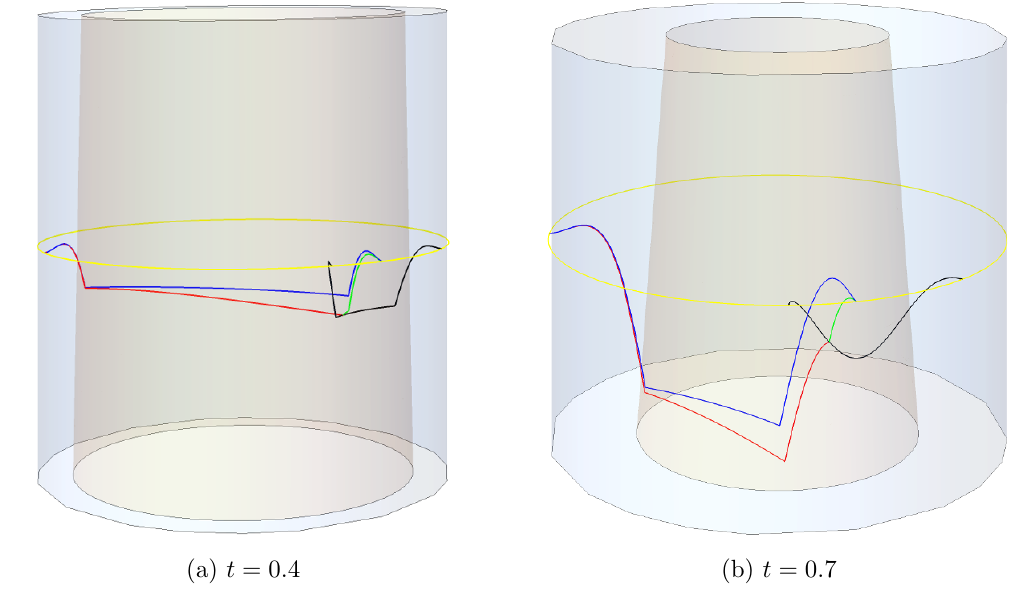
Figure 13. In the (cid:12)gures, the blue cylinder represents the asymptotic boundary, the orange cone denotes the infalling shell and the yellow circle denotes the constant time slice of the boundary. The HRT surfaces (cid:13) ( A ) and (cid:13) ( R ) are in color blue and black. The constrained surface (cid:13) R ( A ) is the union of the red curve and the green